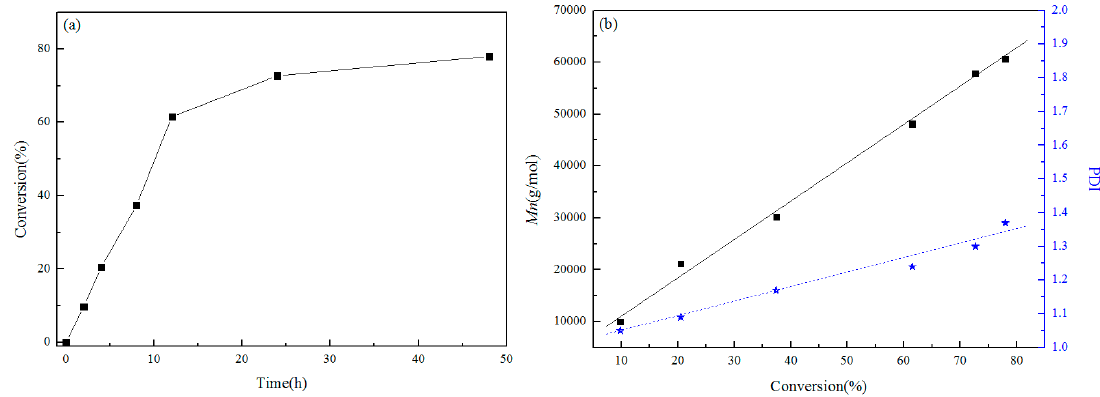
Figure 2. E ff ect of reaction time on conversion rate ( a ) and e ff ect of conversion on Mn and PDI ( b ). Figure 2. Effect of reaction time on conversion rate ( a ) and effect of conversion on Mn and PDI ( b ).